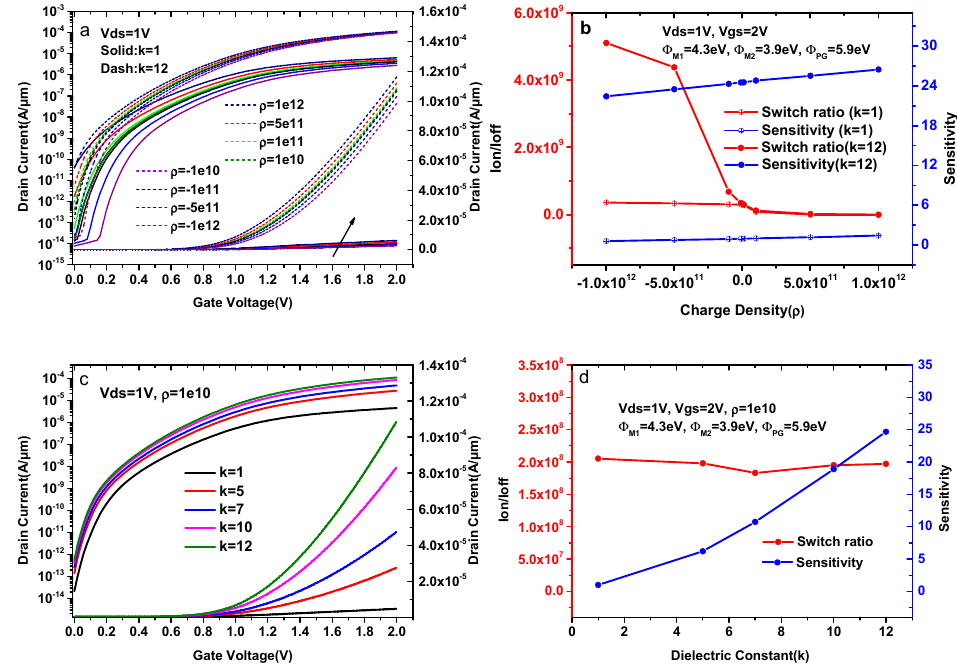
Figure 7. ( a ) Transfer characteristics of DMG-HJLTFET for different charge densities with a fixed dielectric (k = 1 and k = 12); ( b ) the variation of the sensitivity and switch ratio for different charge densities with a fixed dielectric (k = 1 and k = 12); ( c ) Transfer characteristics of DMG-HJLTFET for k = 1, 5, 7, 10, and 12 at a fixed charge ( ρ = 1 × 10 10 cm − 2 ); ( d ) the variation of the sensitivity and switch ratio for k = 1, 5, 7, 10, and 12 at a fixed charge ( ρ = 1 × 10 10 cm − 2 ).